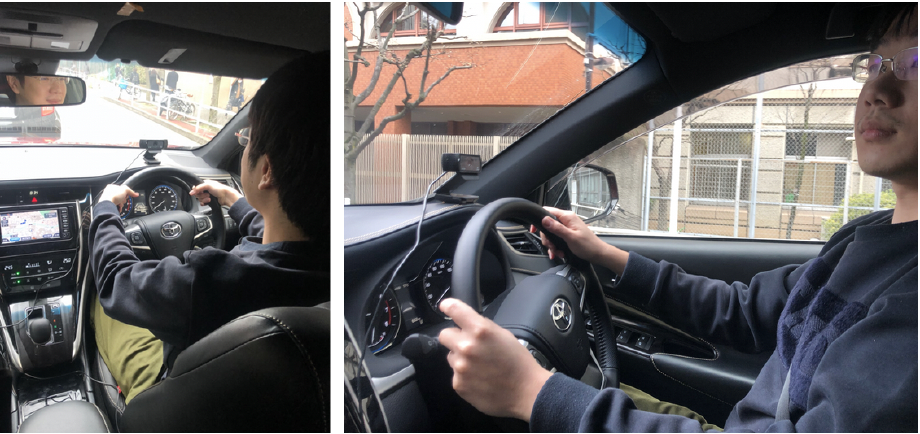
Figure 4. Setup of the experimental environment. The data are collected using only one camera.